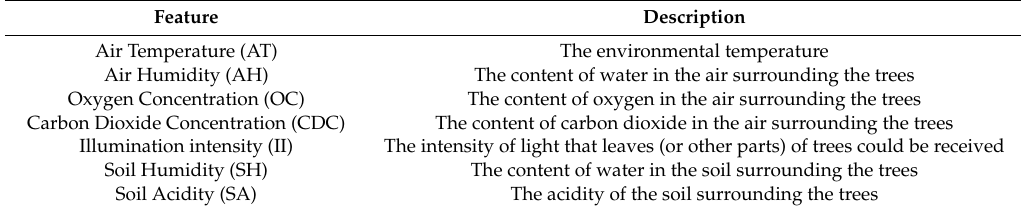
Table 1. Selected proximity environmental feature.